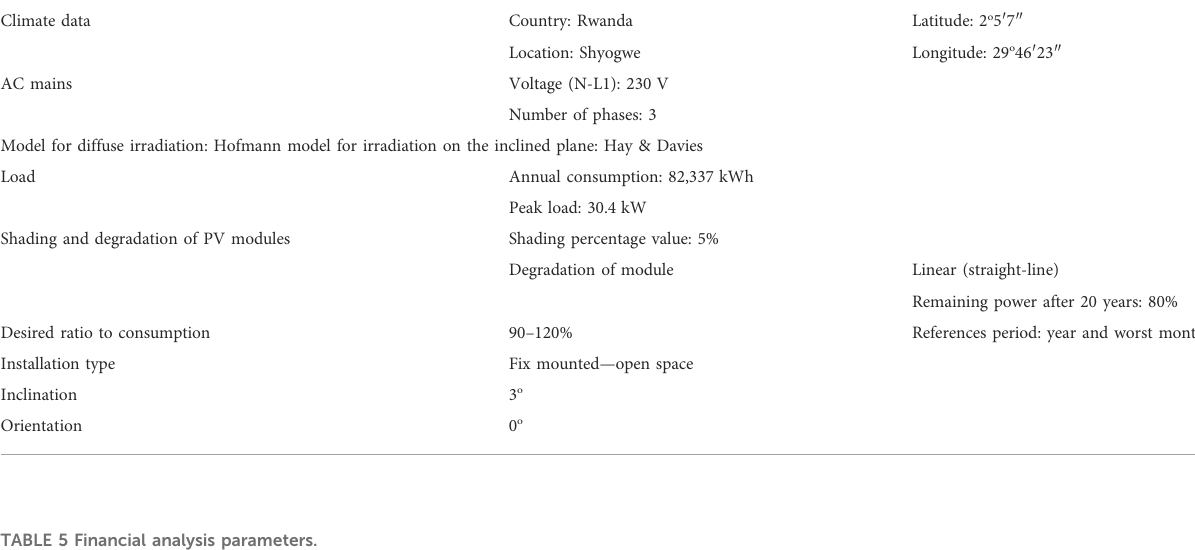
TABLE 5 Financial analysis parameters.